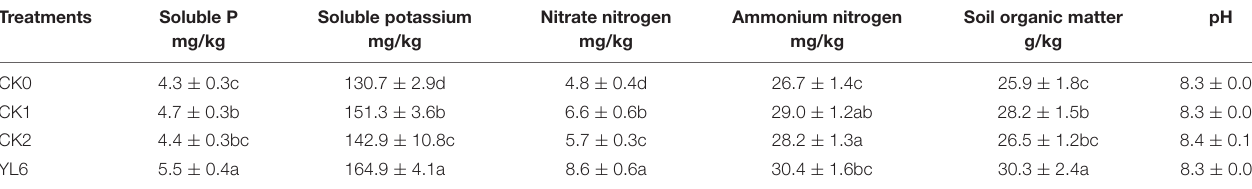
TABLE 3 | Influence of YL6 on soils nutrients for Chinese cabbage under field conditions. Treatments Soluble P mg/kg